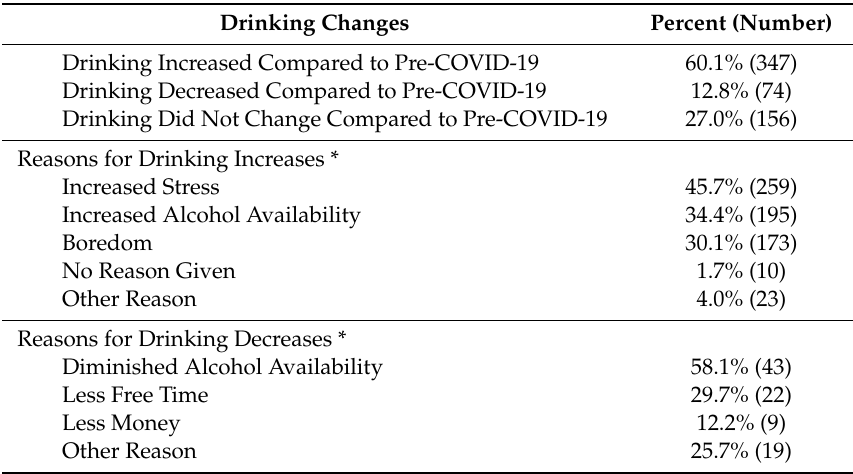
Table 3. Participants’ Perceptions of Drinking Pre- to Post-COVID-19, 2020 ( n =